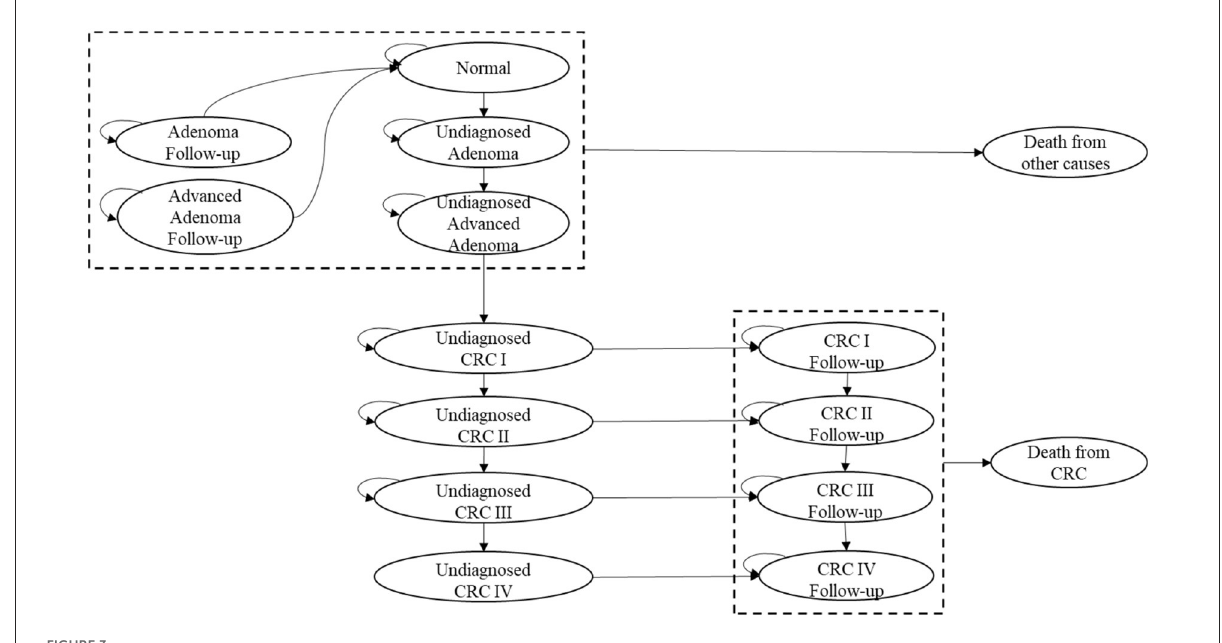
FIGURE3 Structure of the Markov